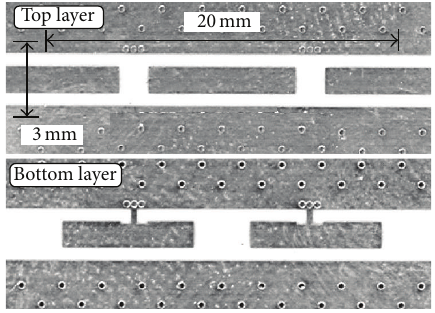
Figure 4: Fabricated microstrip-to-suspended stripline transition.